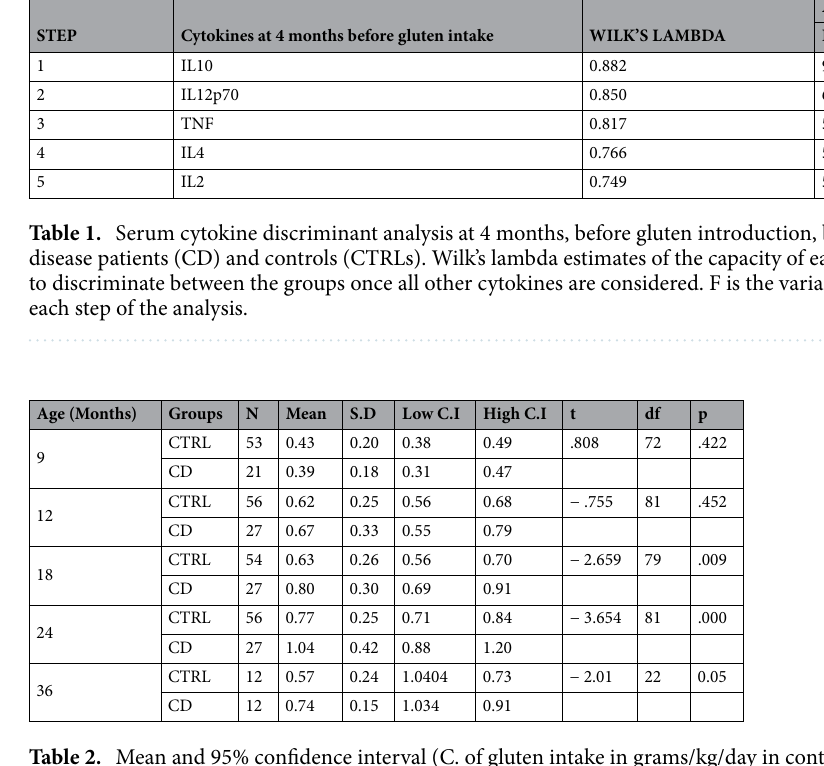
Table 2. Mean and 95% confidence interval (C. of gluten intake in grams/kg/day in controls (CTRLs) and children with celiac disease (CD). Note: in the group of CD cases, gluten at 36 months was estimated only in individuals who had not yet shown any production of anti-transglutaminase antibodies. t = T Student; df = degree of freedom.